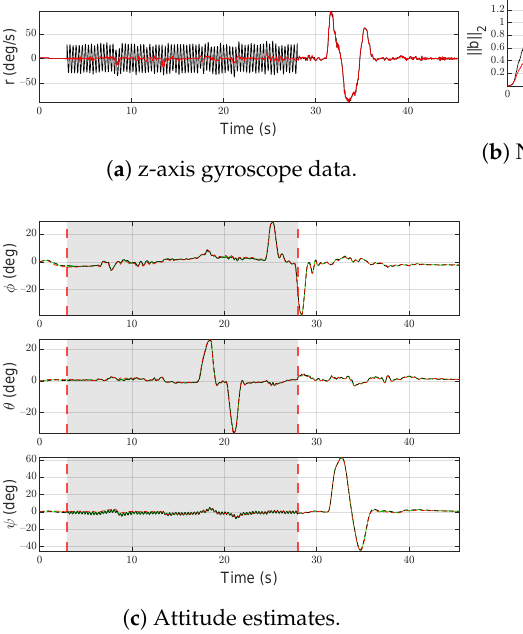
Figure 10. Scenario F4. Black lines denote measurements/estimates from IMU-1, red lines are for measurements/estimates from IMU-2. Green lines represent the output of the system, gray areas highlight the time interval in which the SFDI algorithm is in the fault state. Vertical red dashed lines denote the time instants when the fault occurs and ends.